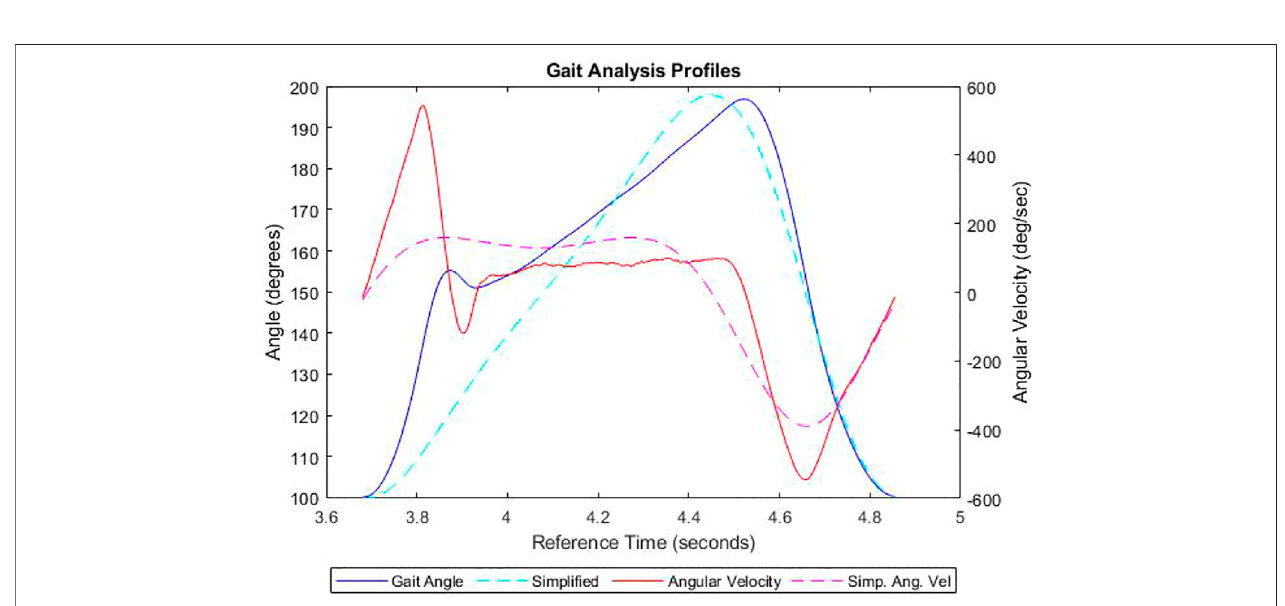
FIGURE 3 | The fl exion angle and associated angular velocities of the human knee joint along with their simpli fi ed plots.